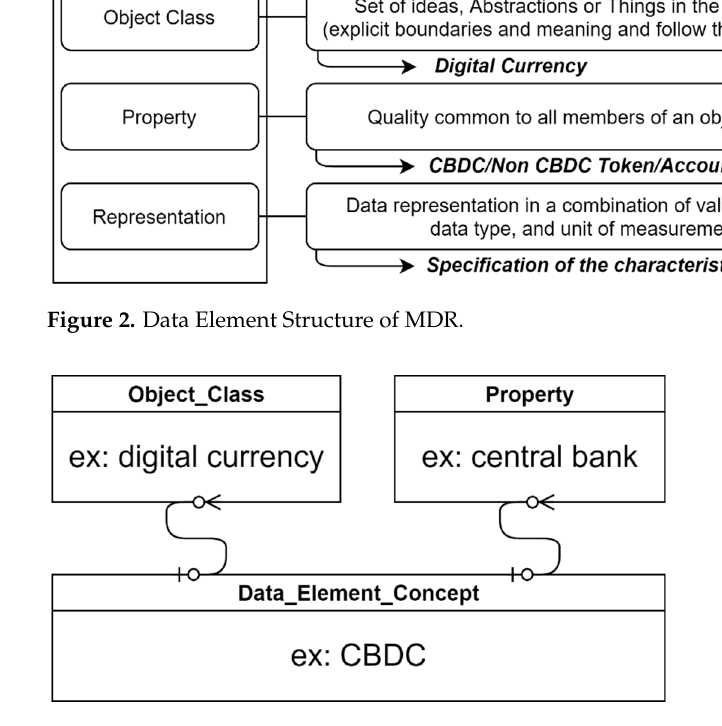
Figure 3. Data Element Concept example of MDR. Future Internet 2021 , 13 , x FOR PEER REVIEW